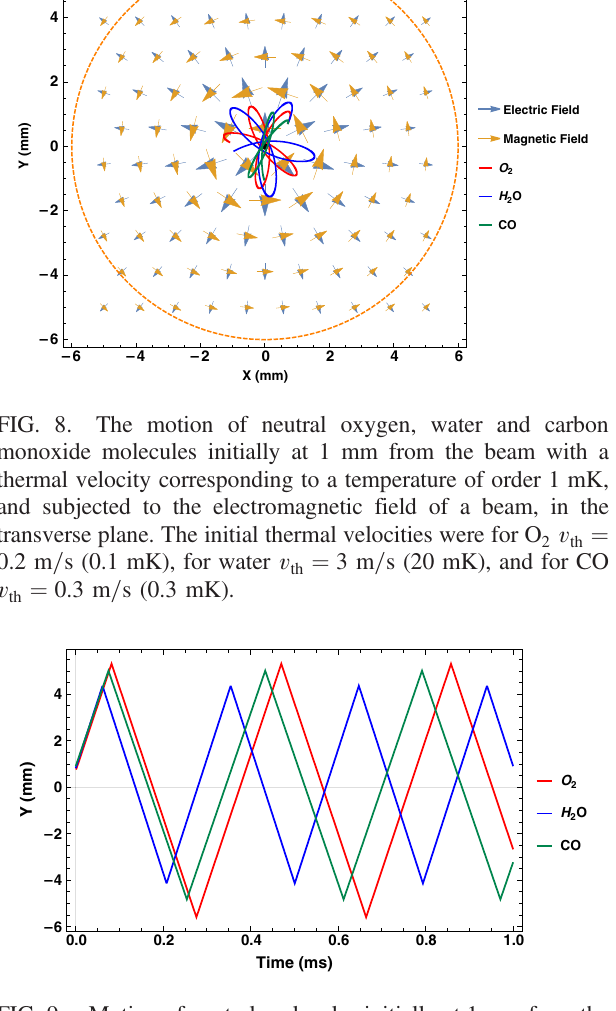
FIG. 9. Motion of neutral molecules initially at 1 mm from the beam with a thermal velocity corresponding to a temperature of 15 K, and subjected to the electromagnetic field of the beam, in the vertical direction, with a hypothetical chamber wall at a radius of 6 mm. Different colors correspond to different molecules as